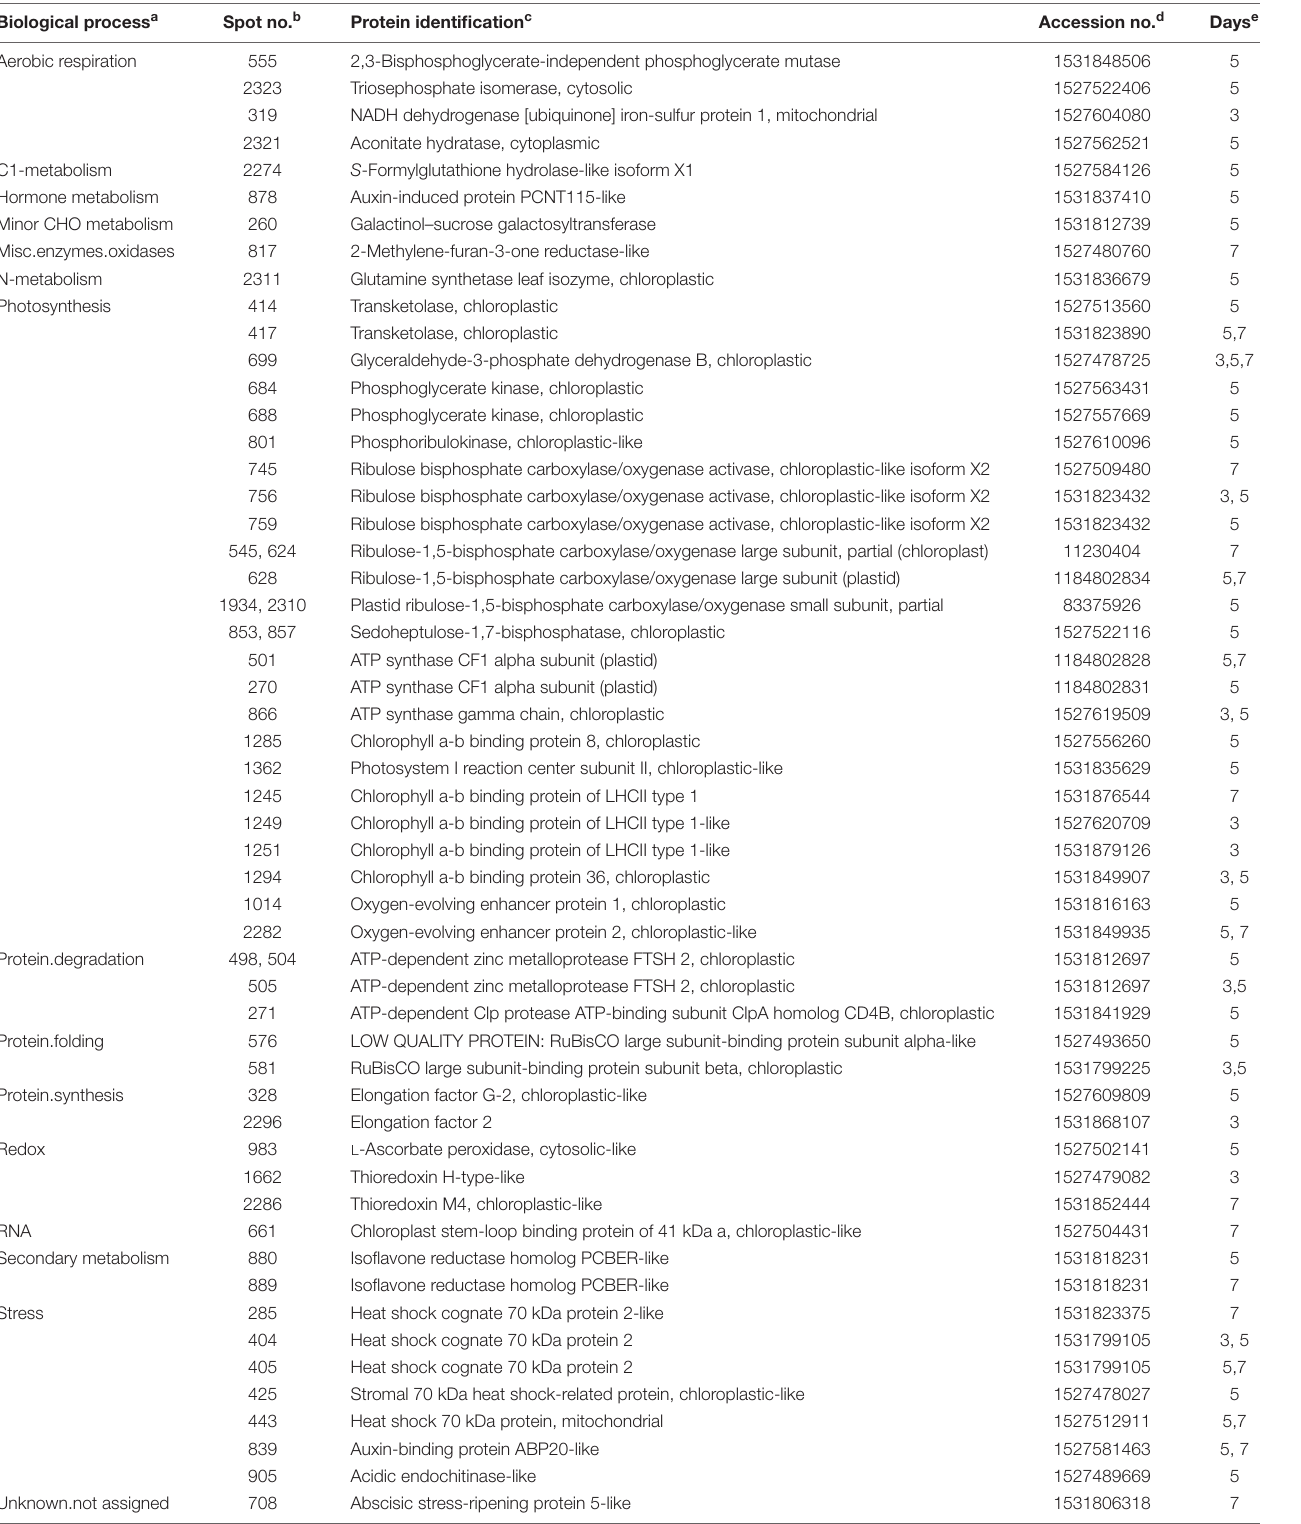
TABLE 2 | Annotation of the coffee leaf proteins that changed in abundance after PRI treatments and H. vastatrix infection. Biological process a Spot no. b Protein identification